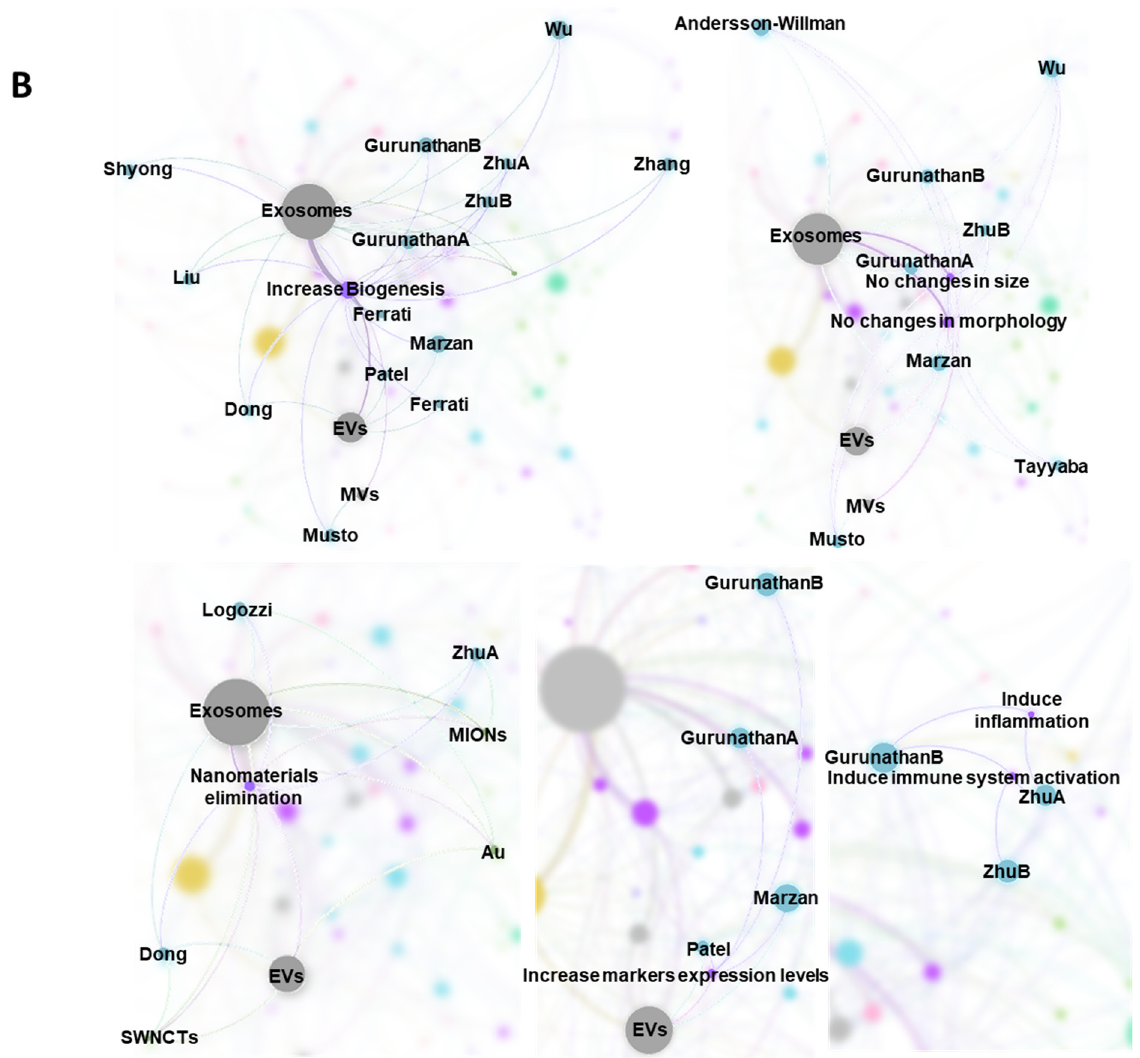
Figure 3. ( A ) Detailed network of the 18 articles that met all the eligibility criteria. The dashed rectangle highlights article [41], summarized in Table 3. In short, [41] used MIONs with a size ranging between 10 and 100 nm. MIONs were exposed to a bronchoalveolar lavage fluid (BALF) extracted from mice, inducing an increase of EVs biogenesis. EVs, with a size between 30 and 100 nm and enriched in TSG101, induced iDC maturation, immune-system activation, and T-cell differentiation. Overall, and regarding all experimental conditions, exosome morphology and size were not affected. ( B ) Most relevant biological outcomes and their connections among the 18 analyzed articles. For instance, despite using different experimental conditions, 15 out of 18 articles pointed to increased EV biogenesis as one of their outcomes. Regarding the duplicated author’s nomenclature, ZhuA, ZhuB, GurunathanA, and GurunathanB correspond to [22,41,44,45],